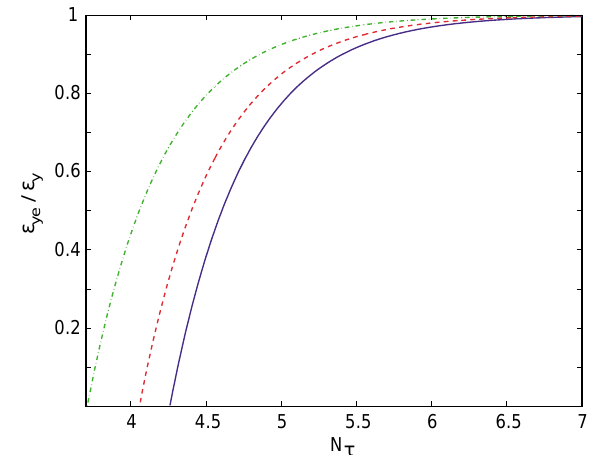
FIG. 1. (Color) Equilibrium vertical emittance divided by an ex- tracted emittance of g´ y (cid:1) 0.03 m m versus relative store time N t for initial emittance values of g´ y 0 (cid:1) 150 m m (solid line), 100 m m (dashed line), and 50 m m (dot-dashed line). A reason- able choice that adequately loosens tolerances is in the region 0.6 , ´ y e (cid:1) ´ y , 0.9